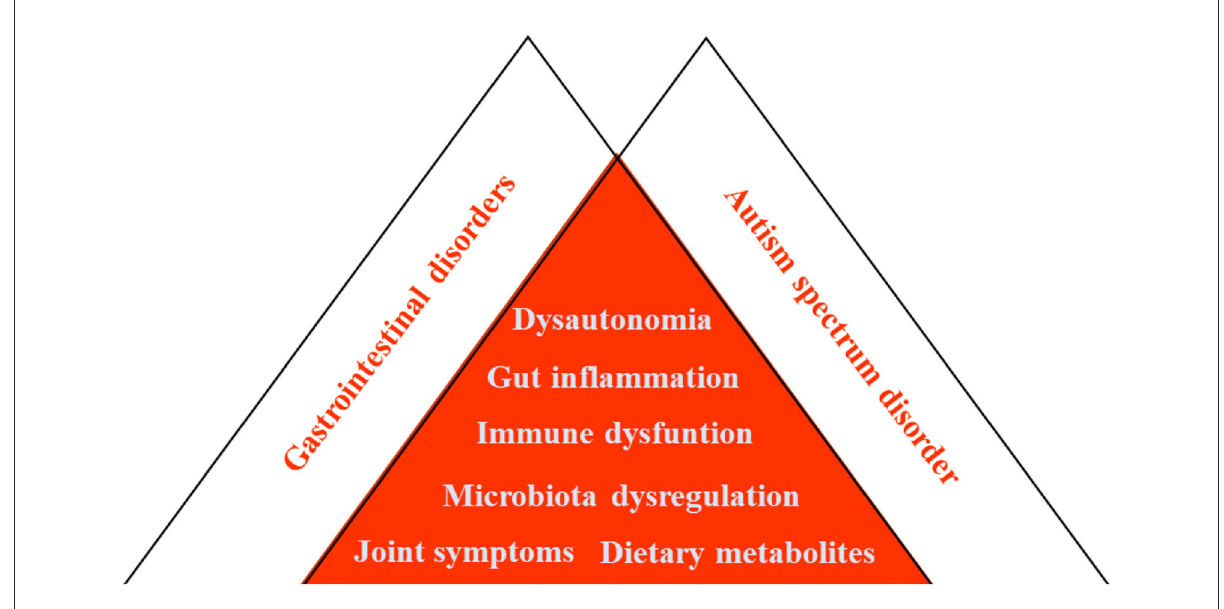
FIGURE12 Concept of the overlap syndrome of GI disorders and